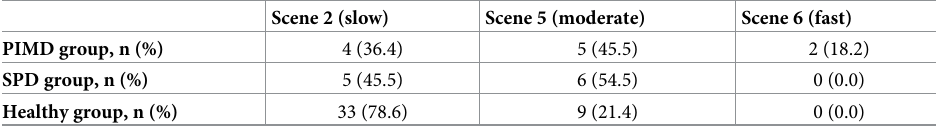
Table 3. Characteristics of subjects of the study’s group with the best distance score based on running